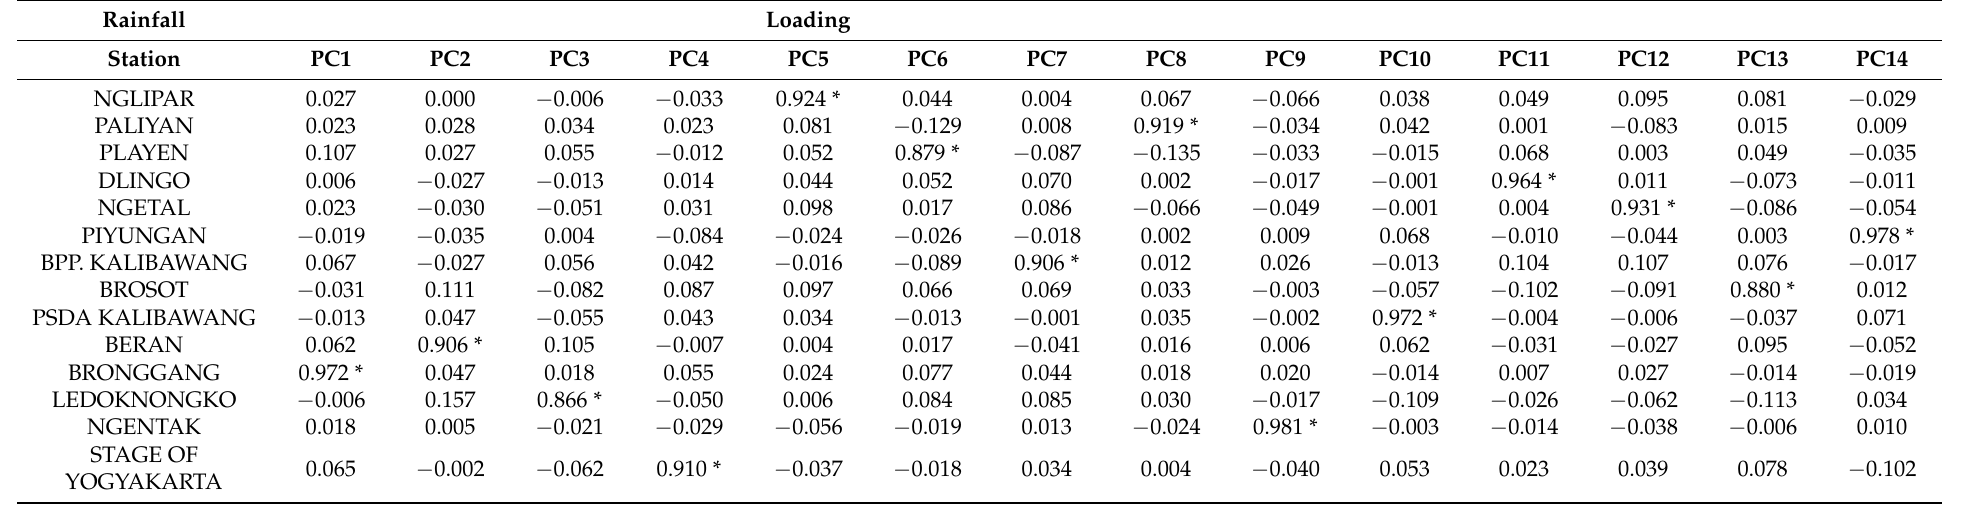
Table 5. Loadings for the first 14 PCs of the Dry Season in Yogyakarta,